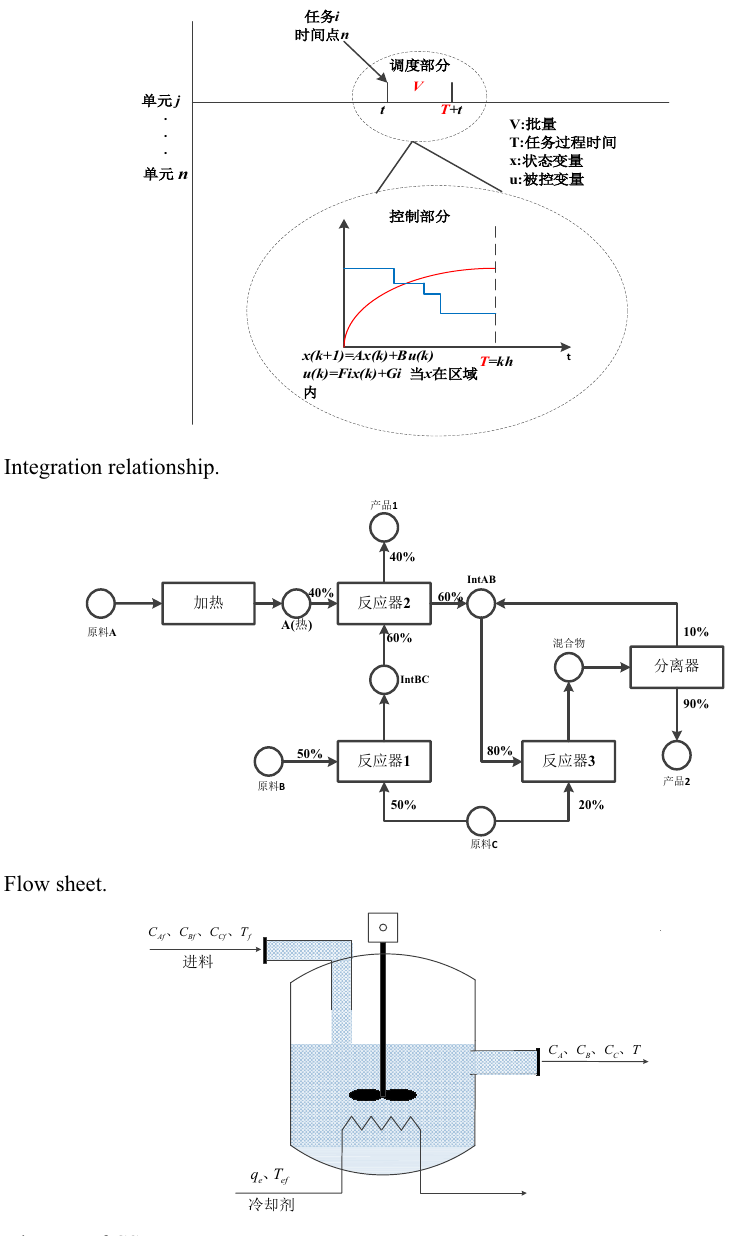
Fig. 4. Diagram of CSTR system.